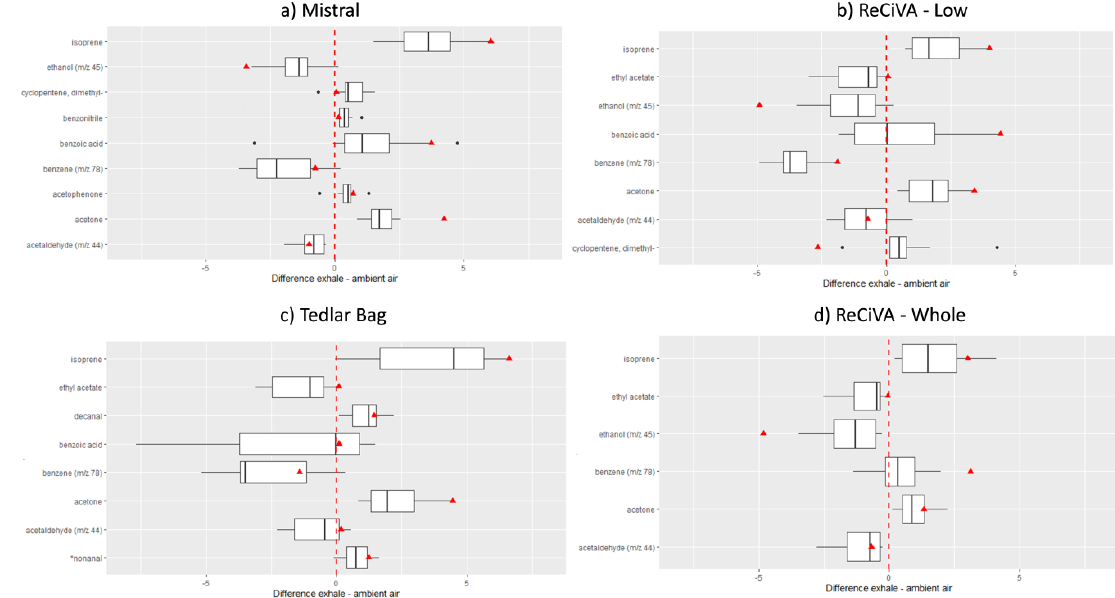
Figure 2. Differences between the normalized peak area of VOCs significantly different at 95% and (*) 90% of significance, respectively, in exhaled breath samples when compared to ambient air samples collected by using Mistral ( a ), ReCIVA Low ( b ), Tedlar bags ( c ), and ReCIVA Whole ( d ). The Red Triangle represents the result related to the only one breath sample collected from a patient affected by Lung Cancer (LC). Black dots represent outliers.